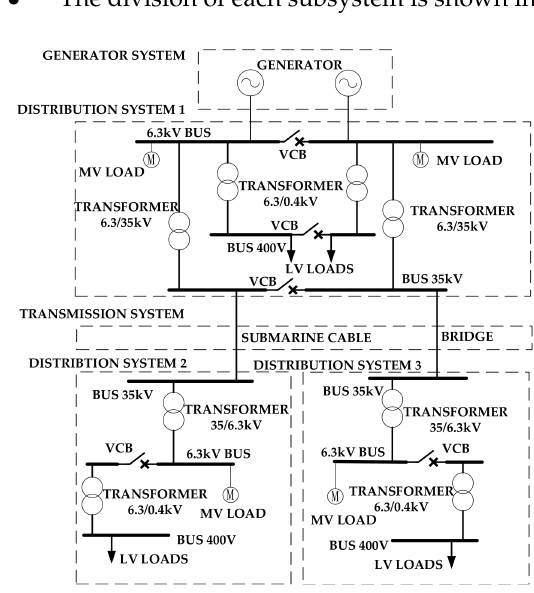
Figure 1. Schematic diagram of subsystem